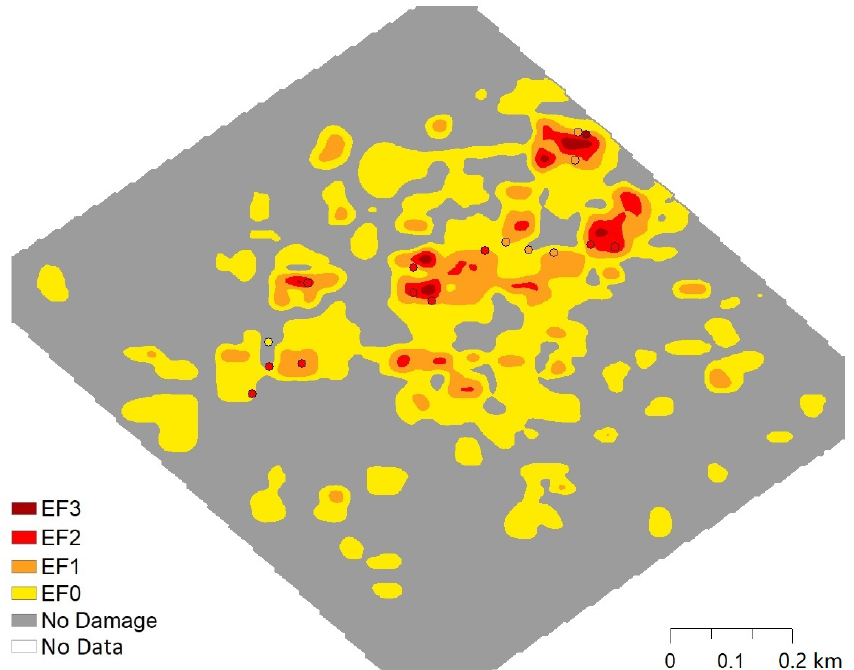
Figure 12. Overlay between GP heatmap from neural network inference and NWS ground survey data points. Circles, which also show damage intensity according to EF scale, are ground-truth data obtained from NWS damage